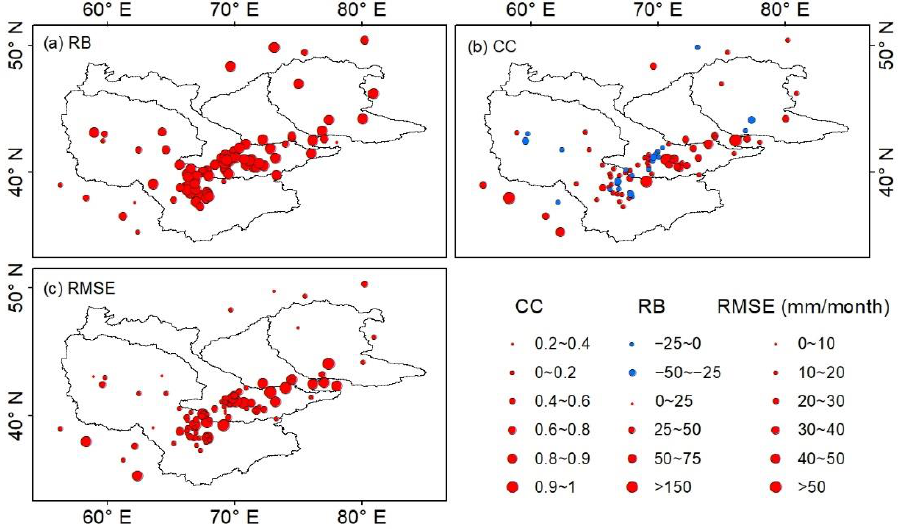
Figure 5. The precipitation spatial patterns of RB, CC, and RMSE of ground sites and MSWEP.